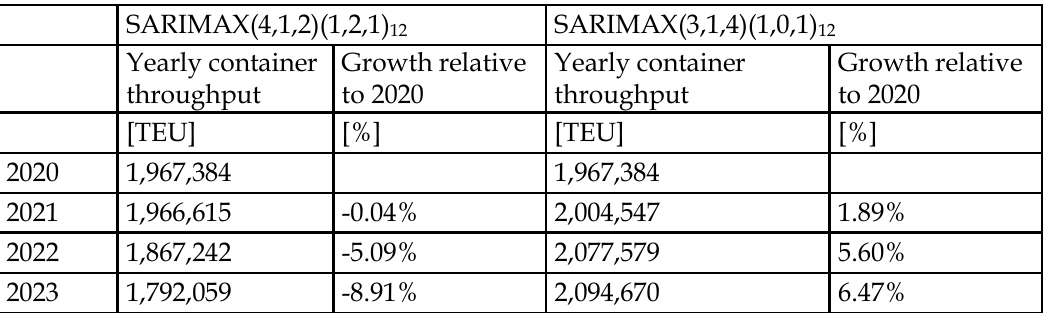
Growth impact of the two SARIMAX